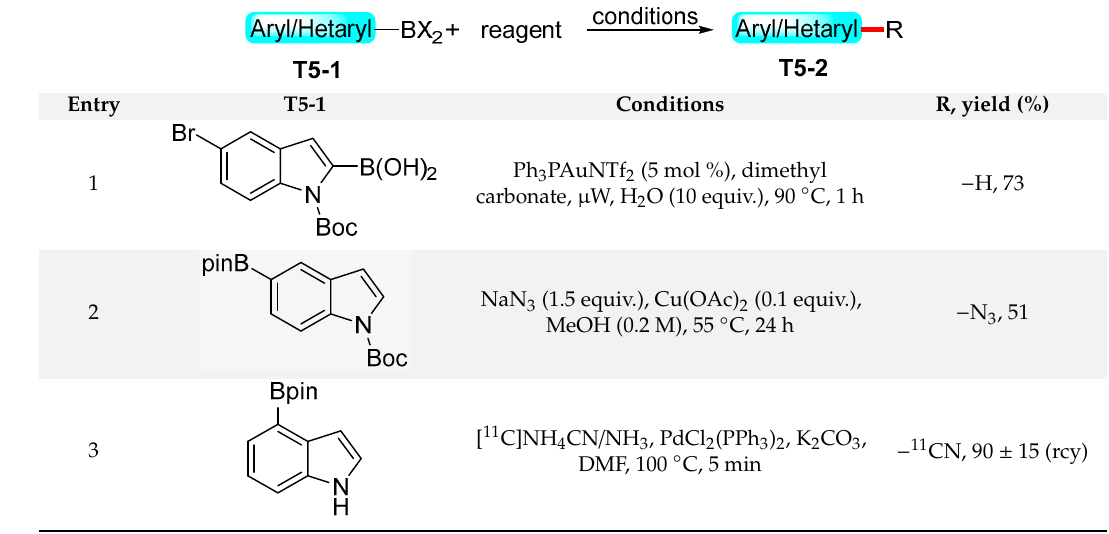
Table 5. Simple transition-metal-catalyzed modifications of indolylboronic acids.